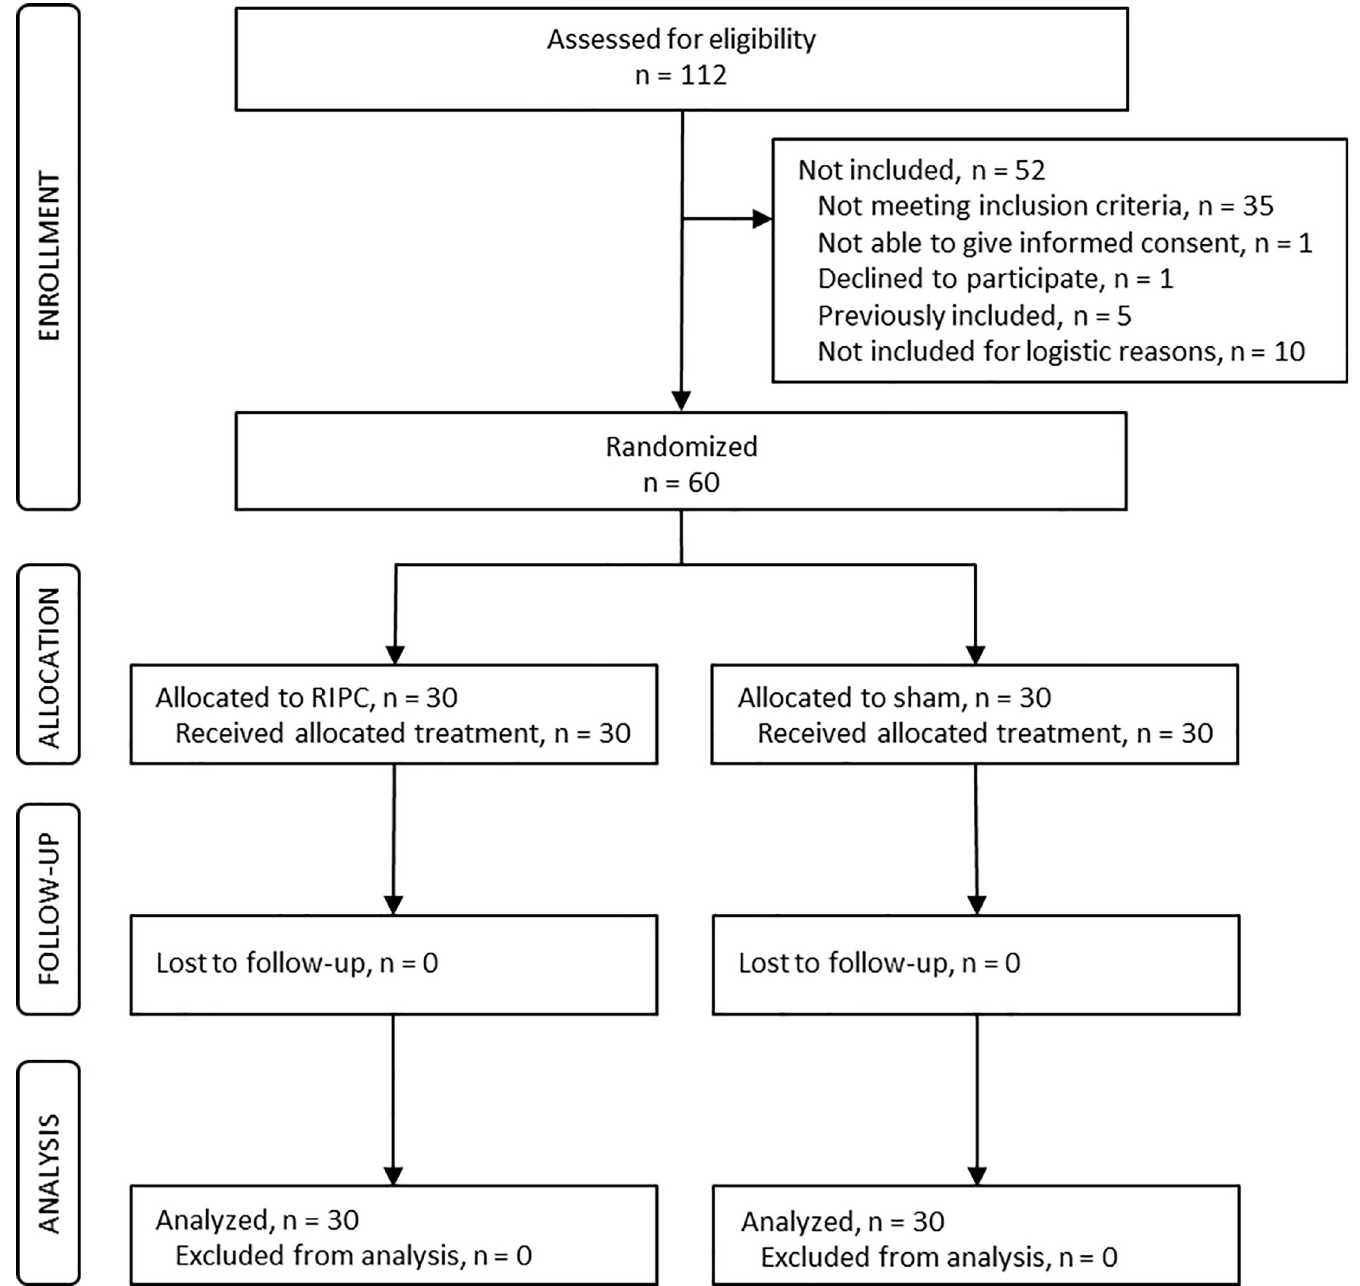
Fig 1. Flow diagram of patient inclusion. Sixty patients were randomized (1:1) to remote ischemic preconditioning (RIPC) or sham intervention. All patients received the allocated intervention and no patients were lost to follow-up. All patients were included in the intention-to-treat analyses.